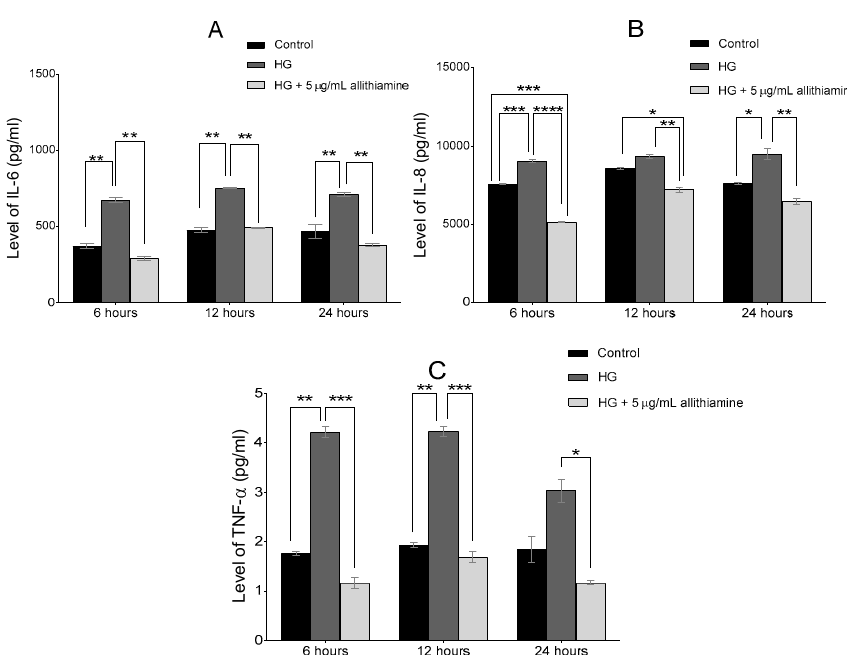
Figure 5. Effect of allithiamine on the activation of NF- κ B in HUVECs after 6 and 12 h. Data are expressed as the mean ± SEM of three individual experiments *, **, and *** mark significant ( p < 0.05, p < 0.005, and p < 0.0005) differences between the control and HG, and between HG and HG+5 μ g/mL allithiamine, HG: hyperglycaemia (30 mMol/L glucose).